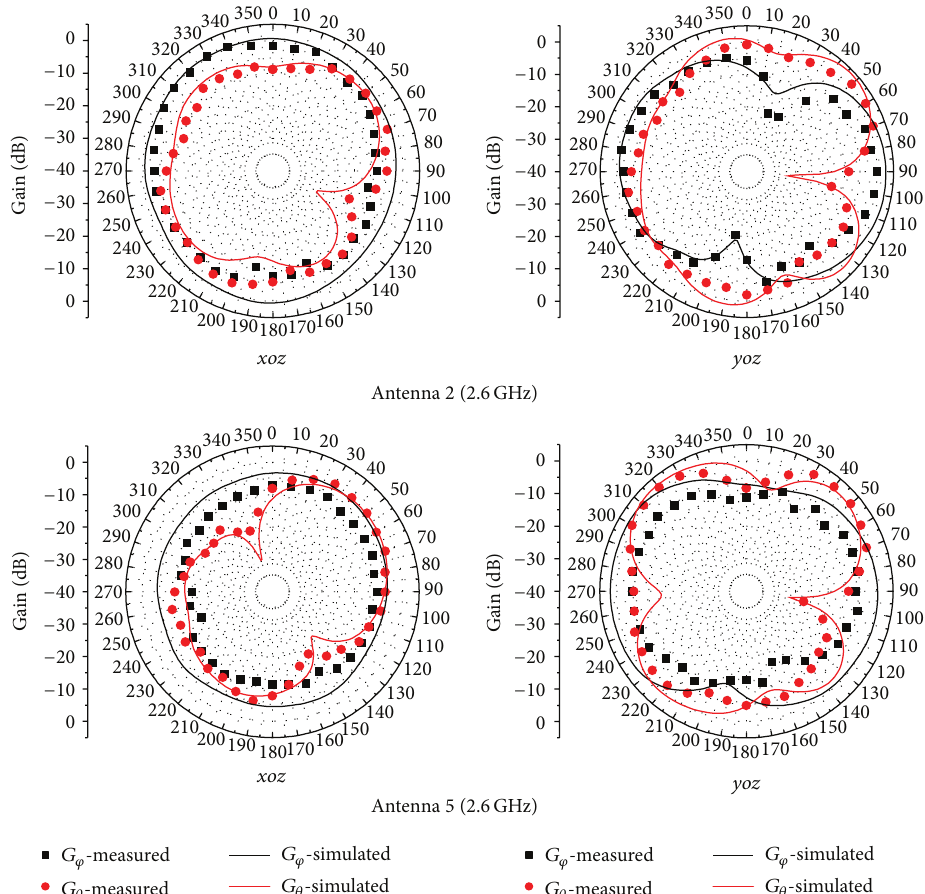
Figure 14: Measured and simulated radiation patterns of antennas 1, 2, and 5 at 1.9 GHz and 2.6 GHz.